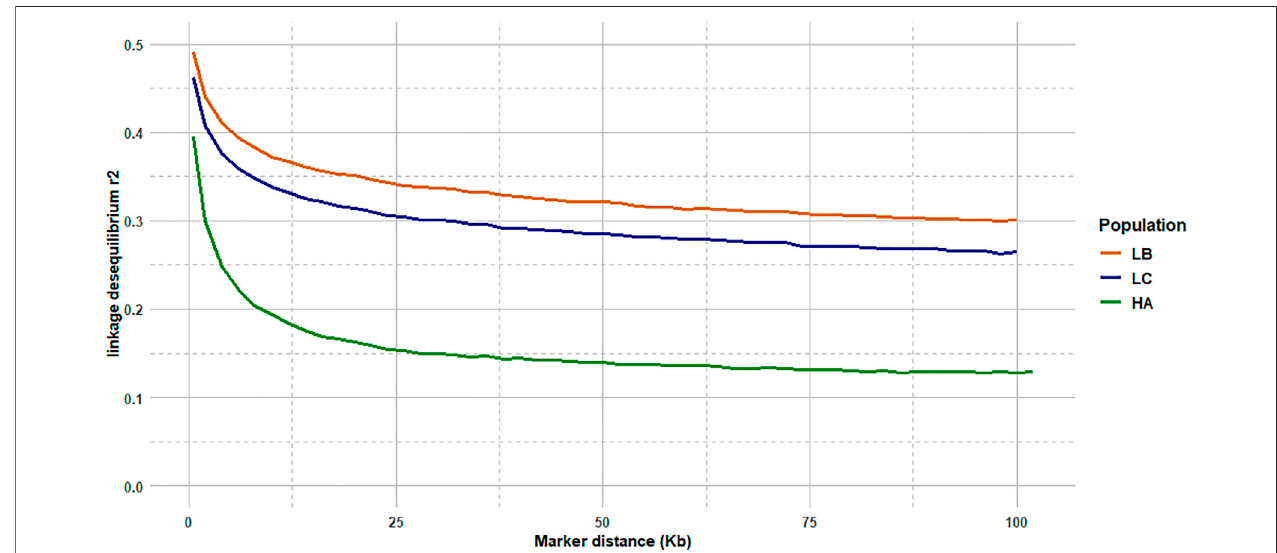
FIGURE7| LDdecayfrom2to100 kbintermarkerdistances(averageoverthe32chromosomes)fortheLBandLCFrenchcommerciallinesandtheHAAmerican population.